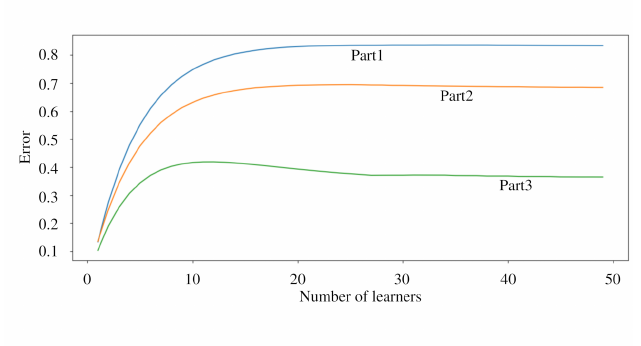
Figure 6. Number of learners (regression trees) vs. the error of the GB model for misrun prediction. Each line represents different test components in the casting. Part 1 and Part 2 are related to tensile tests in different locations. Part 3 is a flat plate